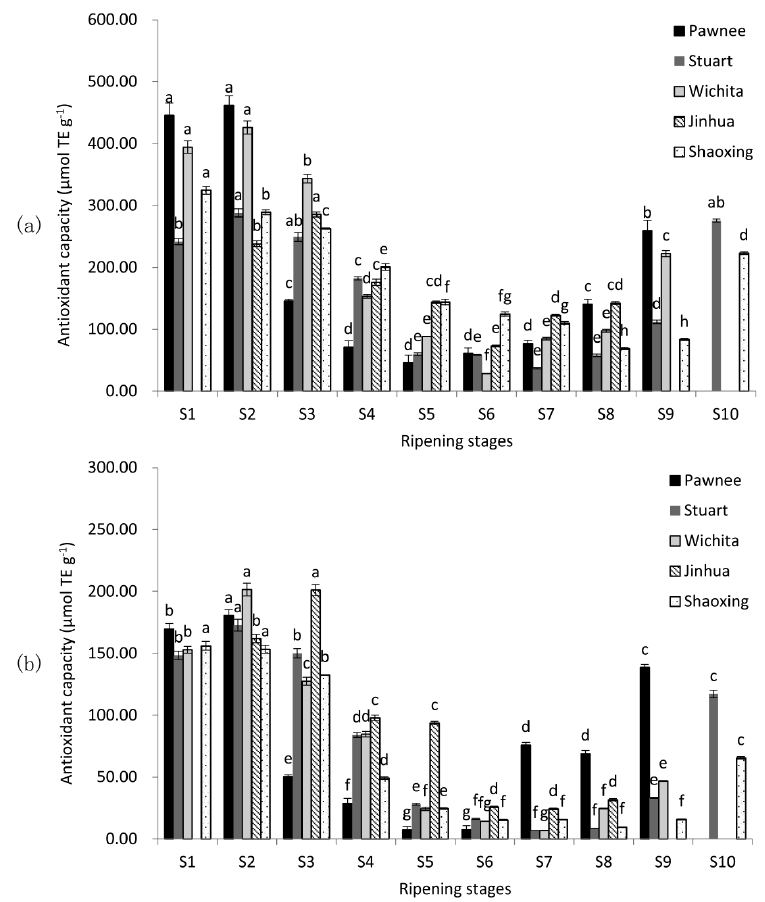
Figure 2. Changes in DPPH ( a ) and ABTS ( b ) during the ripening of pecan kernels. Each value is a mean ± standard deviation of triplicate analysis results of different samples. Means with different letters in each line were significantly different according to the multiple-range Tukey’s test at p < 0.05. Although the high antioxidant capacity of pecan kernel was reported before [3,4,10], no report